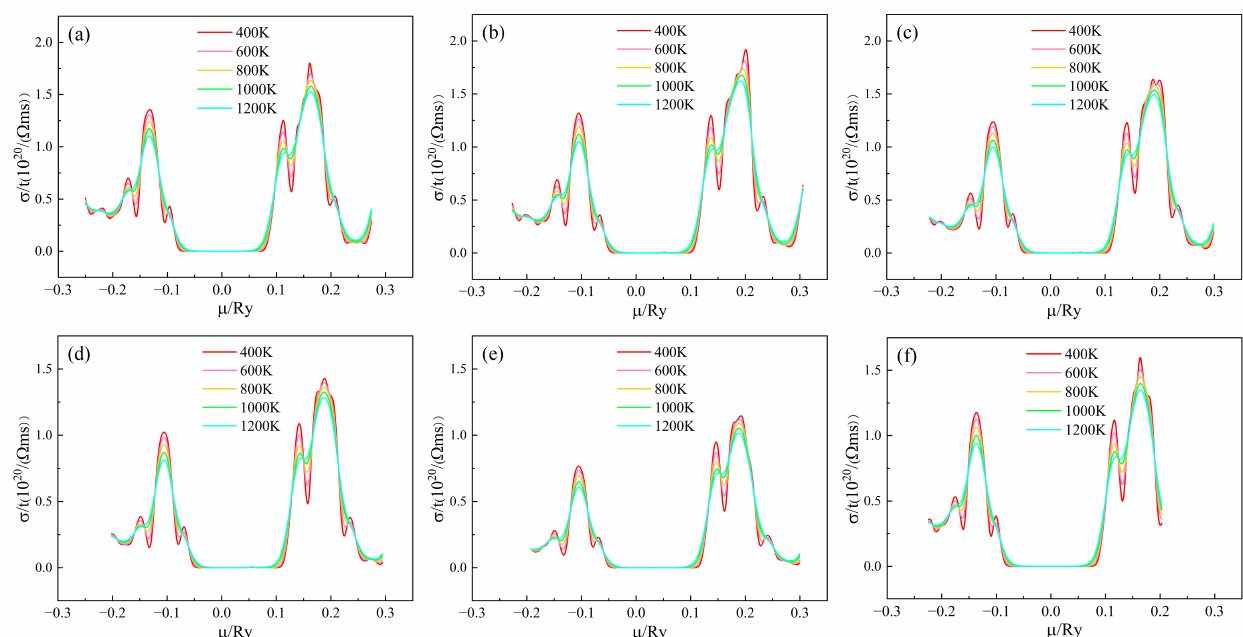
Figure 5. Chemical potential dependent of σ / τ of (Sr 0.889-x La 0.111 Bi x )TiO 2.963. ( a ) Sr 0.889 La 0.111 TiO 2.963; ( b ) Sr 0.852 La 0.111 Bi 0.037 TiO 2.963; ( c ) Sr 0.815 La 0.111 Bi 0.074 TiO 2.963; ( d ) Sr 0.778 La 0.111 Bi 0.111 TiO 2.963; ( e ) Sr 0.741 La 0.111 Bi 0.148 TiO 2.963; ( f ) Sr 0.815 La 0.185 TiO 2.963 .